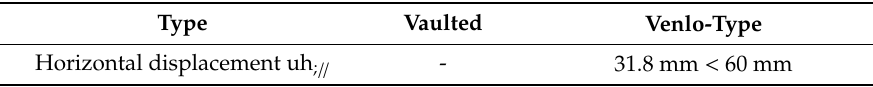
Table 10. Horizontal displacement uh ;// after strengthening.